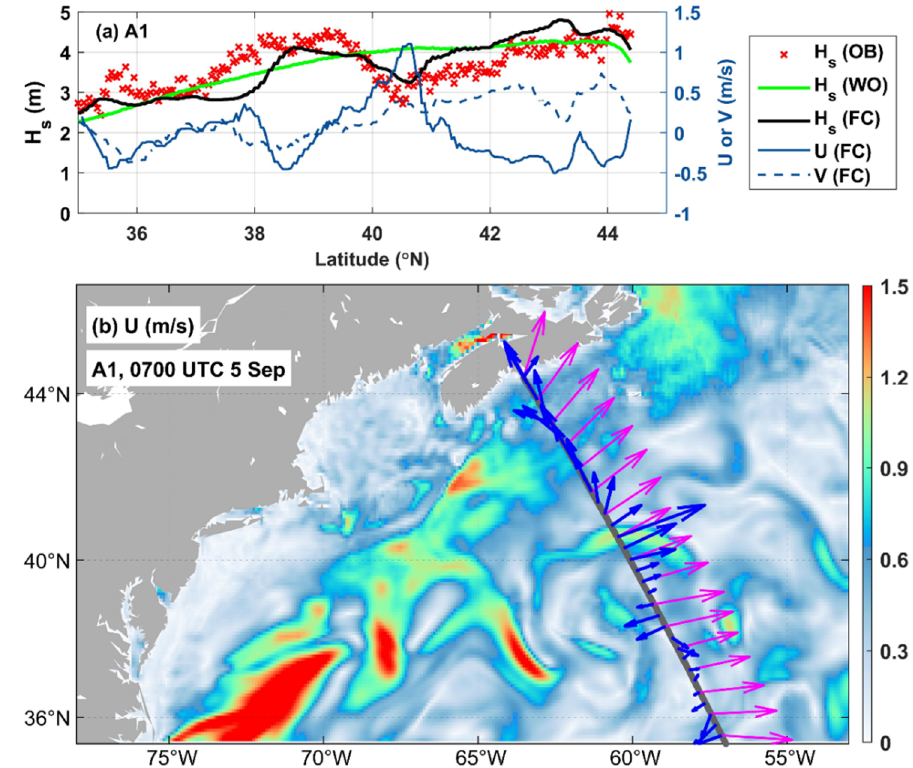
Figure 7. ( a ) Distributions of SWHs (left axis) and depth-weighted currents (right axis) along track A1. ( b ) The altimeter track A1 (thick gray line) overlays on the current magnitudes (color shading). The wave (magenta arrow) and current directions (blue arrow) in run FC are also shown. Lengths of the magenta and blue arrows represent mean wave periods and current speeds, respectively.